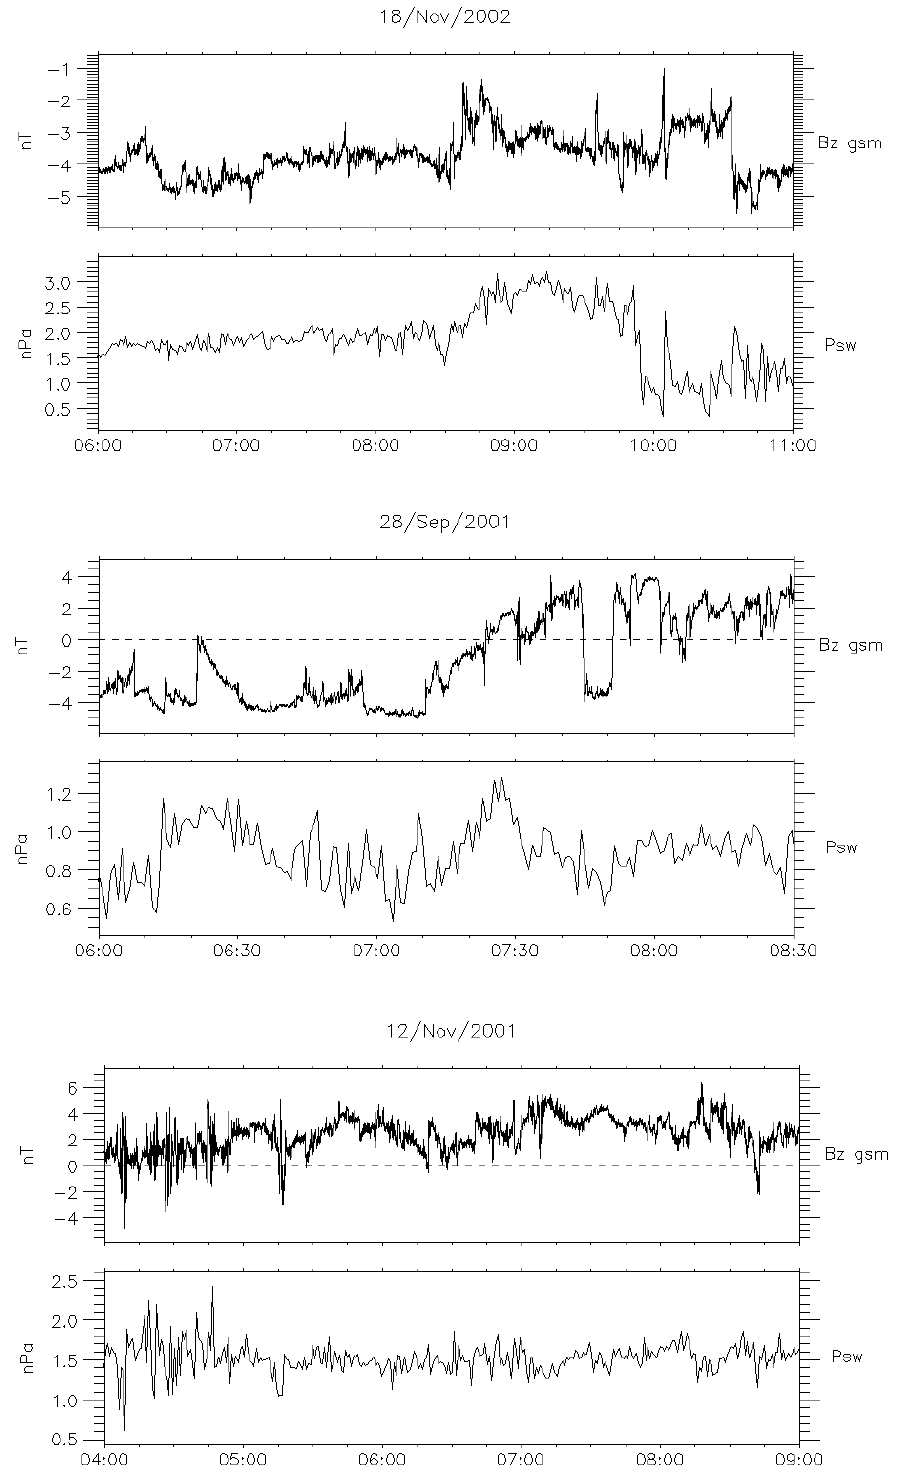
Fig. 6. IMF B z component and solar wind pressure as provided by GEOTAIL for the polar cap crossings displayed in Fig. 1.